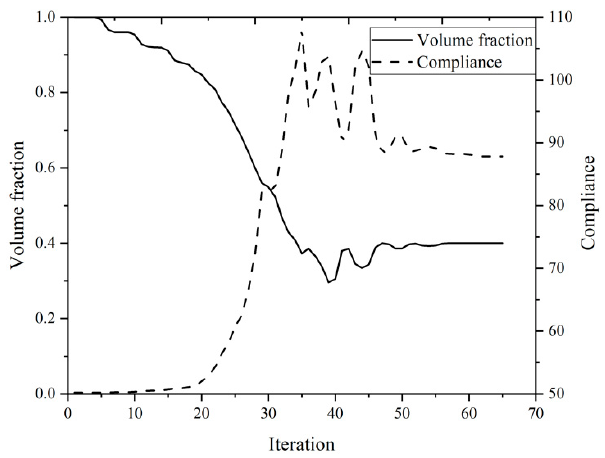
Figure 4. Preliminary optimized shape of L-shaped beam.